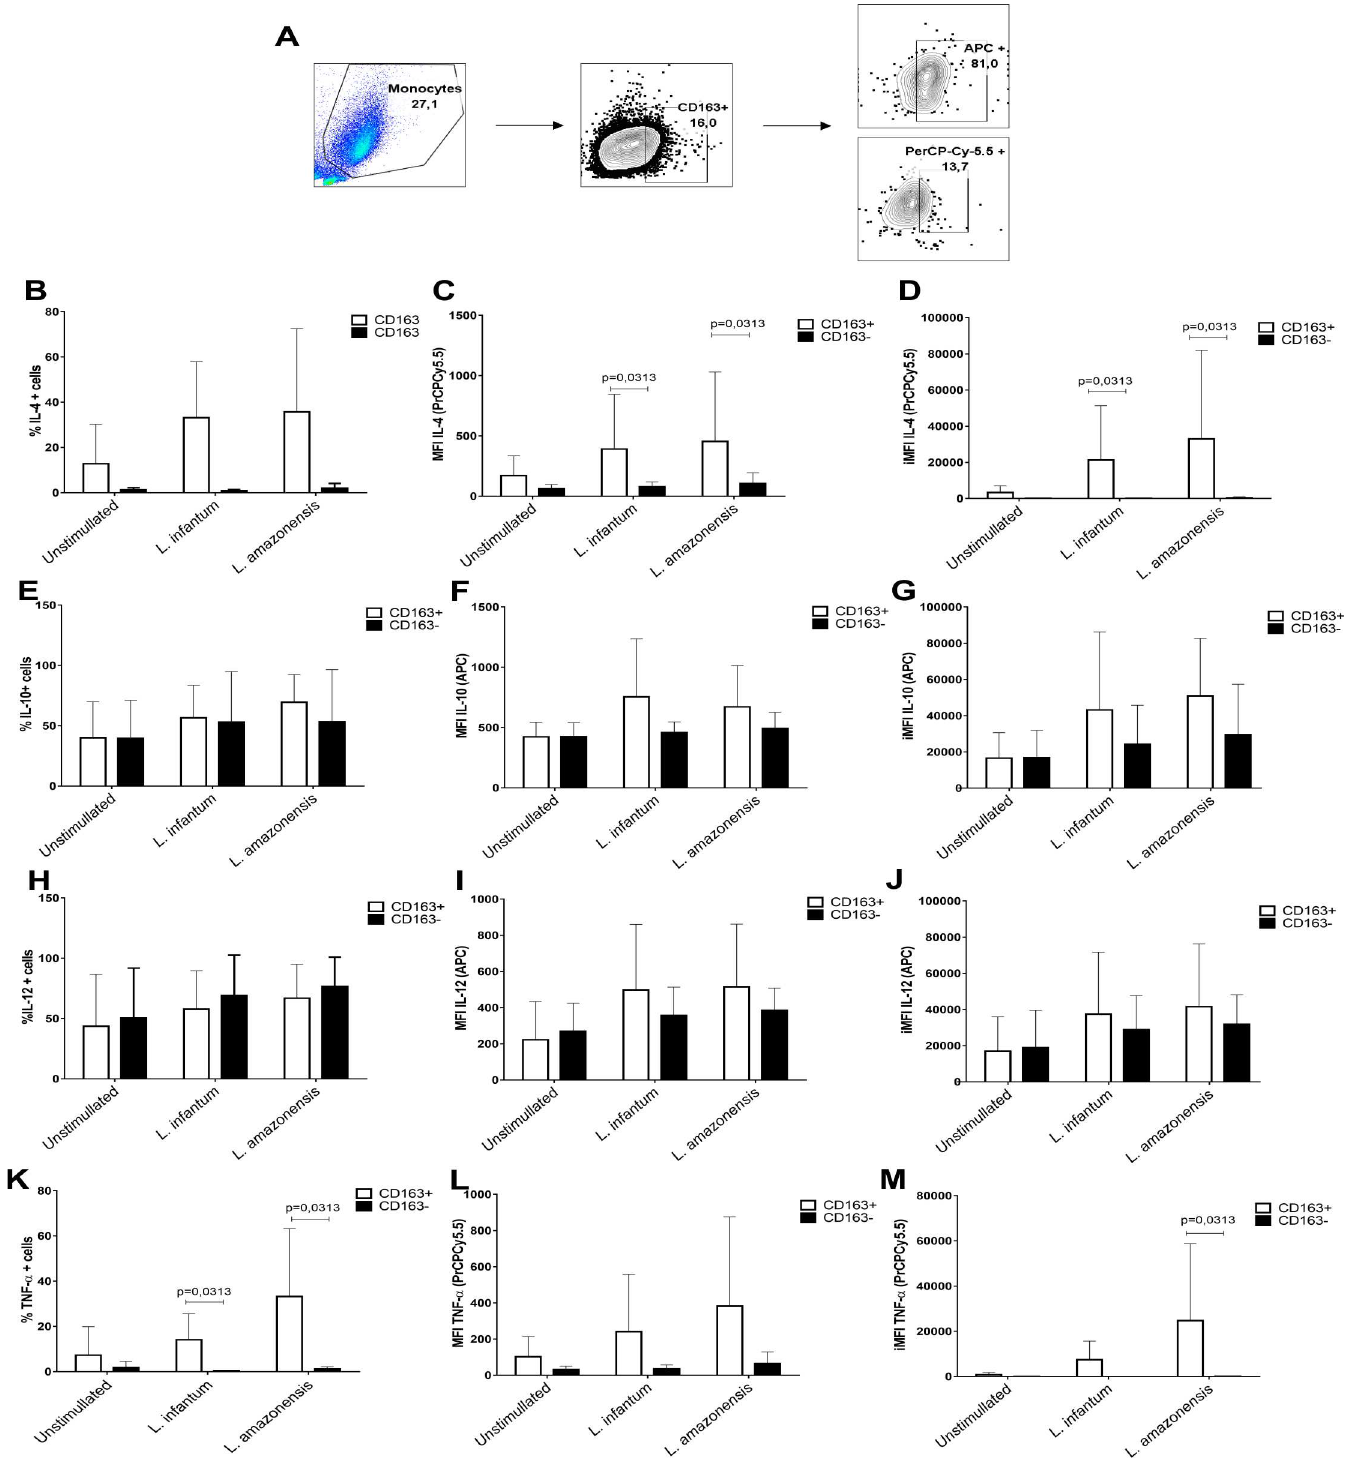
Fig 4. Variable cytokine production by CD163+ and CD163-monocyte/macrophages. (A) Gating strategy for analysisof the cytokine profiles of CD163 + and CD163- monocyte/macrophages. PBMC were collectedfrom healthydonors and the adherentcells culturedfor 5 days in RPMI 1640 plus 20% FBS. The cells were incubatedwith L . amazonensis strain (10 parasites: 1 macrophage) and L . infantum- isolate1 (5:1), and incubatedwith antibodiesspecific for intracellularcytokines, prior to analysisby flow cytometry (n = 6 experiments, in duplicate). (B) Frequency of IL-4+ cells, (C) MFI of IL-4-PerCPCy5.5, (D) iMFI of IL-4 analysis, (E) Frequency of IL-10+ cells, (F) MFI of IL-10-APC, (G) iMFI of IL-10 analysis, (H) Frequency of IL-12+ cells, (I) MFI of IL-12-APC, (J) iMFI of IL-12 analysis, (K) Frequency of TNF- α + cells, (L) MFI of TNF- α -PerCPCy5.5, (M) iMFI of TNF- α analysis. https://doi.org/10.1371/journal.pntd.0005486.g004 PLOS NeglectedTropical Diseases | https://doi.org/10.1371/journal.pntd.0005486 March 29,